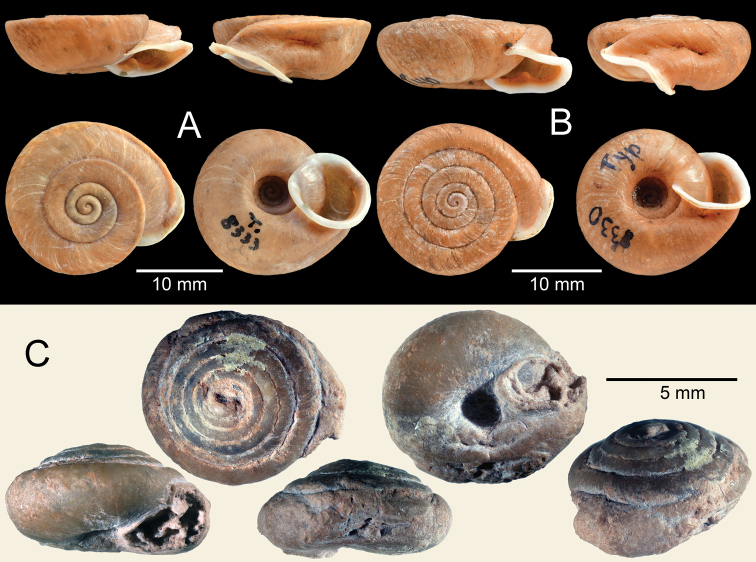
AMoellendorffiella
erdmanni, lectotype SMF 8333/1 BMoellendorffiella
faberiana, holotype SMF 8330/1 CMoellendorffia
?
polygyrella, holotype NIGPAS 36428. Photo: T Yü (C).